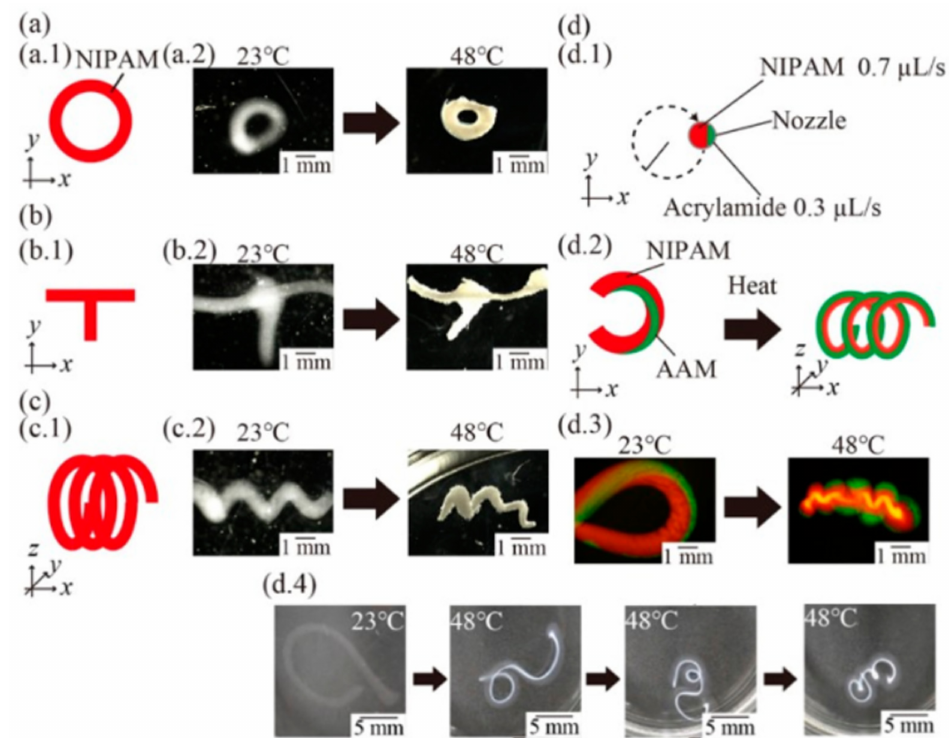
Figure 7. A validation of a 4D printing process. ( a ) Schematic presentation of printed structures and heated structures with a rounded pattern. ( b ) Schematic presentation and images of a printed T-shaped structure and a heated T-shaped structure with a cross point. ( c ) Schematic presentation of a printed spring structure and heated spring structure with an internal gap. ( d ) Schematic presentation of printing a C-shaped structure with multihydrogels ( d.1 ) and its 3D shape changing from the C- shaped structure to the spring-shaped structure. ( d.2 ) Fluorescence images of the fabricated C-shaped structure ( d.3 ) and the transformed spring structure obtained by heating. ( d.4 ) Time-lapse images of the C-shaped structure. Reprinted with permission from reference [61], Copyright 2020 by the authors and license MDPI, Basel, Switzerland.